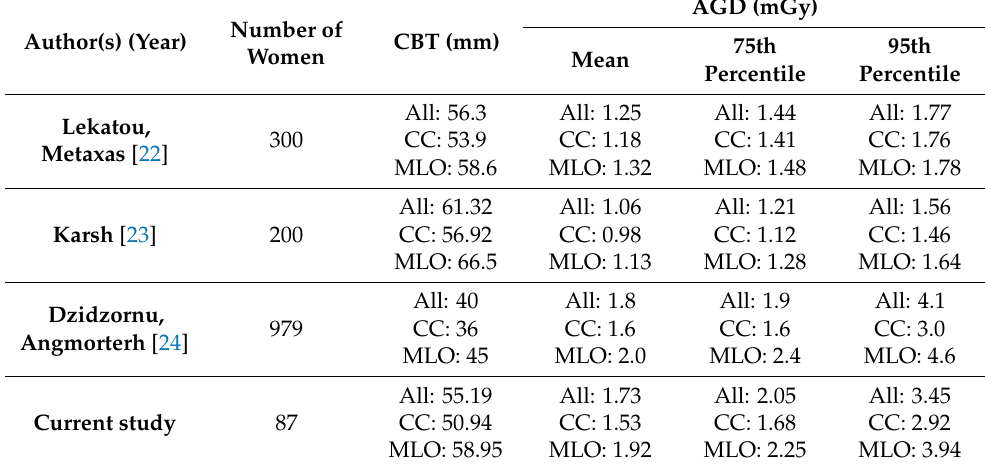
Table 7. Comparison of the compressed breast thickness (CBT) and AGD values of full-field digital mammography (FFDM) at 75th and 95th percentile with corresponding previously published